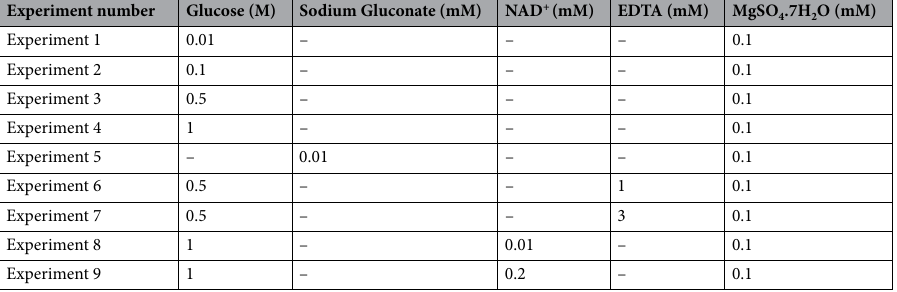
Table 1. Different concentrations of components for ethanol production in the Z. mobilis crude